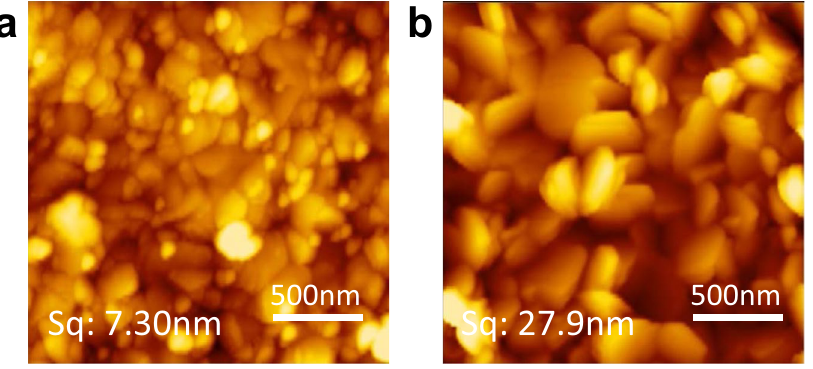
Figure 4. AFM images of PbI 2 films vacuum deposited ( a ) without co-evaporant, and ( b ) with co-evaporant. Sq is the root mean square height, which is standardized by ISO25178 as one of the parameters representing surface